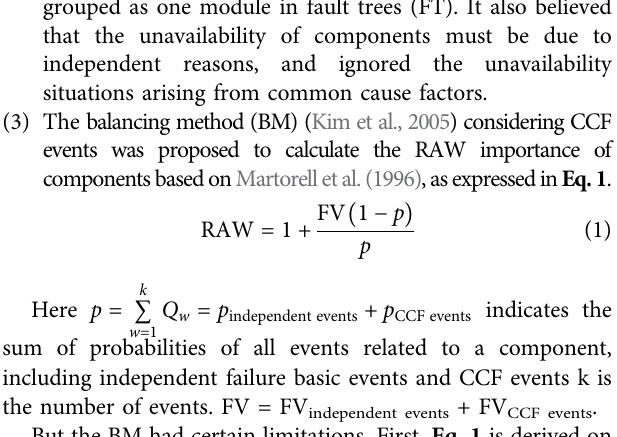
Frontiers in Energy Research |